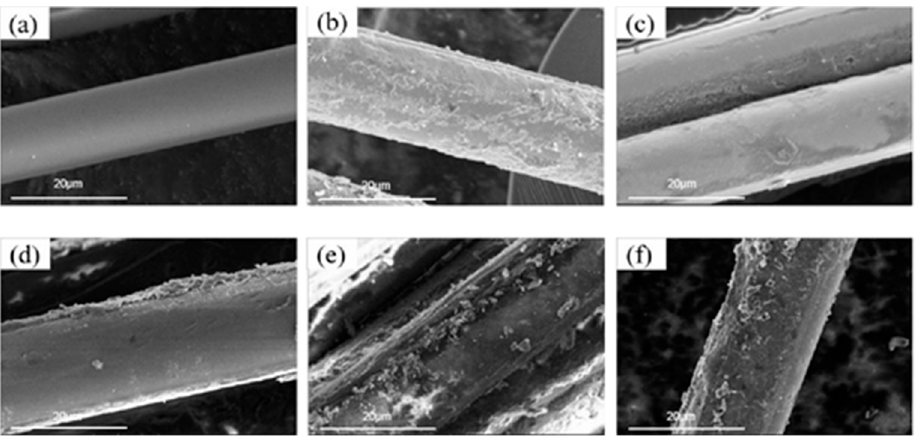
Figure 6. SEM images of BF under different treatment conditions at 20 μ m: ( a ) BF, ( b ) BF H , ( c ) PDA- BF, ( d ) PDA-BF H , ( e ) PDA-BF-SiCB, ( f ) PDA-BF H -SiCB. ( d ) PDA-BF H , ( e ) PDA-BF-SiCB, ( f ) PDA-BF H